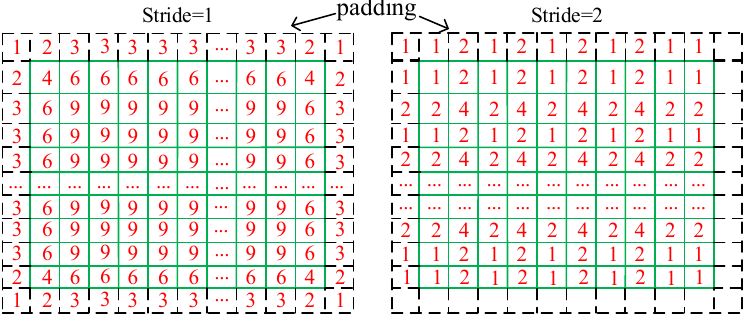
Figure 5. 3 × 3 convolution reuse coefficient α under different strides.